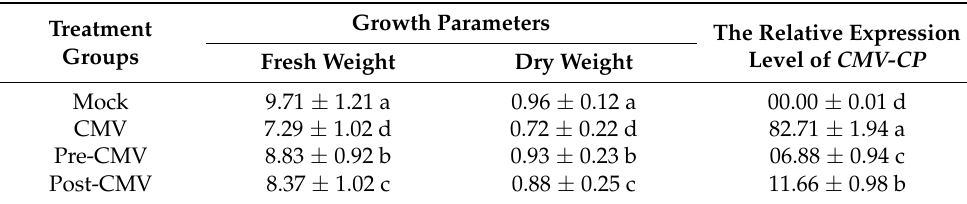
Table 2. The growth parameters of squash plants under CMV challenges with corresponding viral accumulation levels as affected with Ag-NPs foliar treatment.